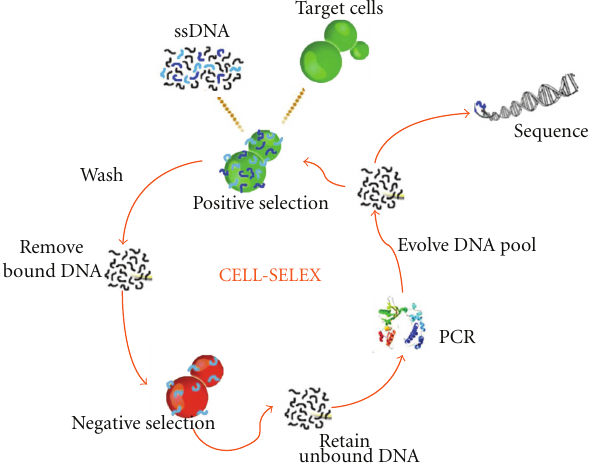
F 3: Schematic diagram of cell-SELEX